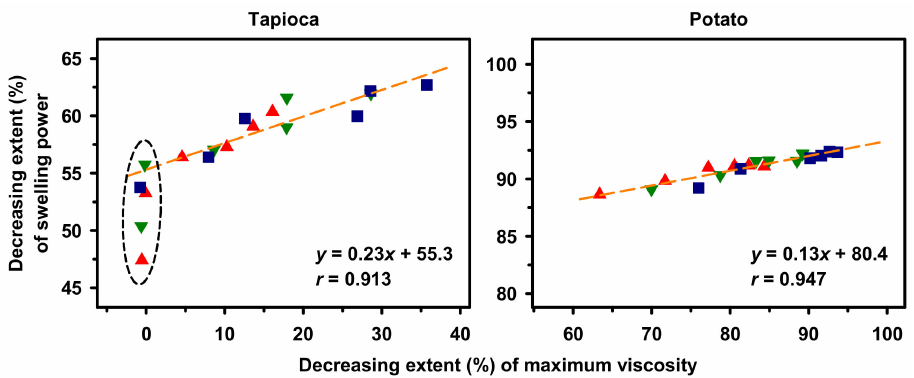
Figure 7. Regression of decreasing extent of swelling power on that of maximum viscosity for heat–moisture treated starches. Holding time: 0 ( (cid:78) ), 30 ( (cid:72) ) and 60 ( (cid:4) )